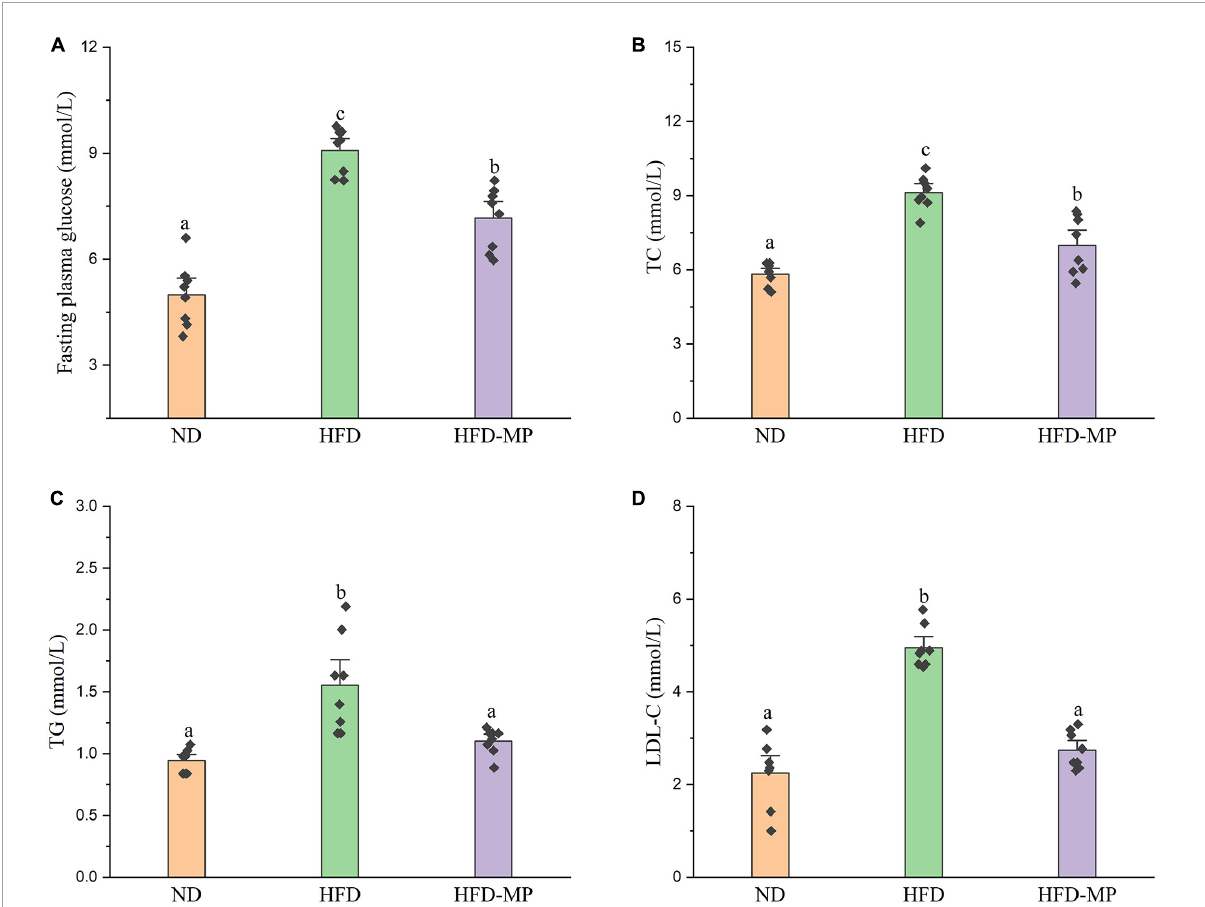
FIGURE2 MP intervention reduced HFD-induced high levels of (A) fasting plasma glucose, (B) TC, (C) TG, and (D) LDL-C in plasma. The data are represented as the mean ± SEM. Statistical differences were carried out by one-way ANOVA followed by Turkey’s test, p < 0.05 indicates significant